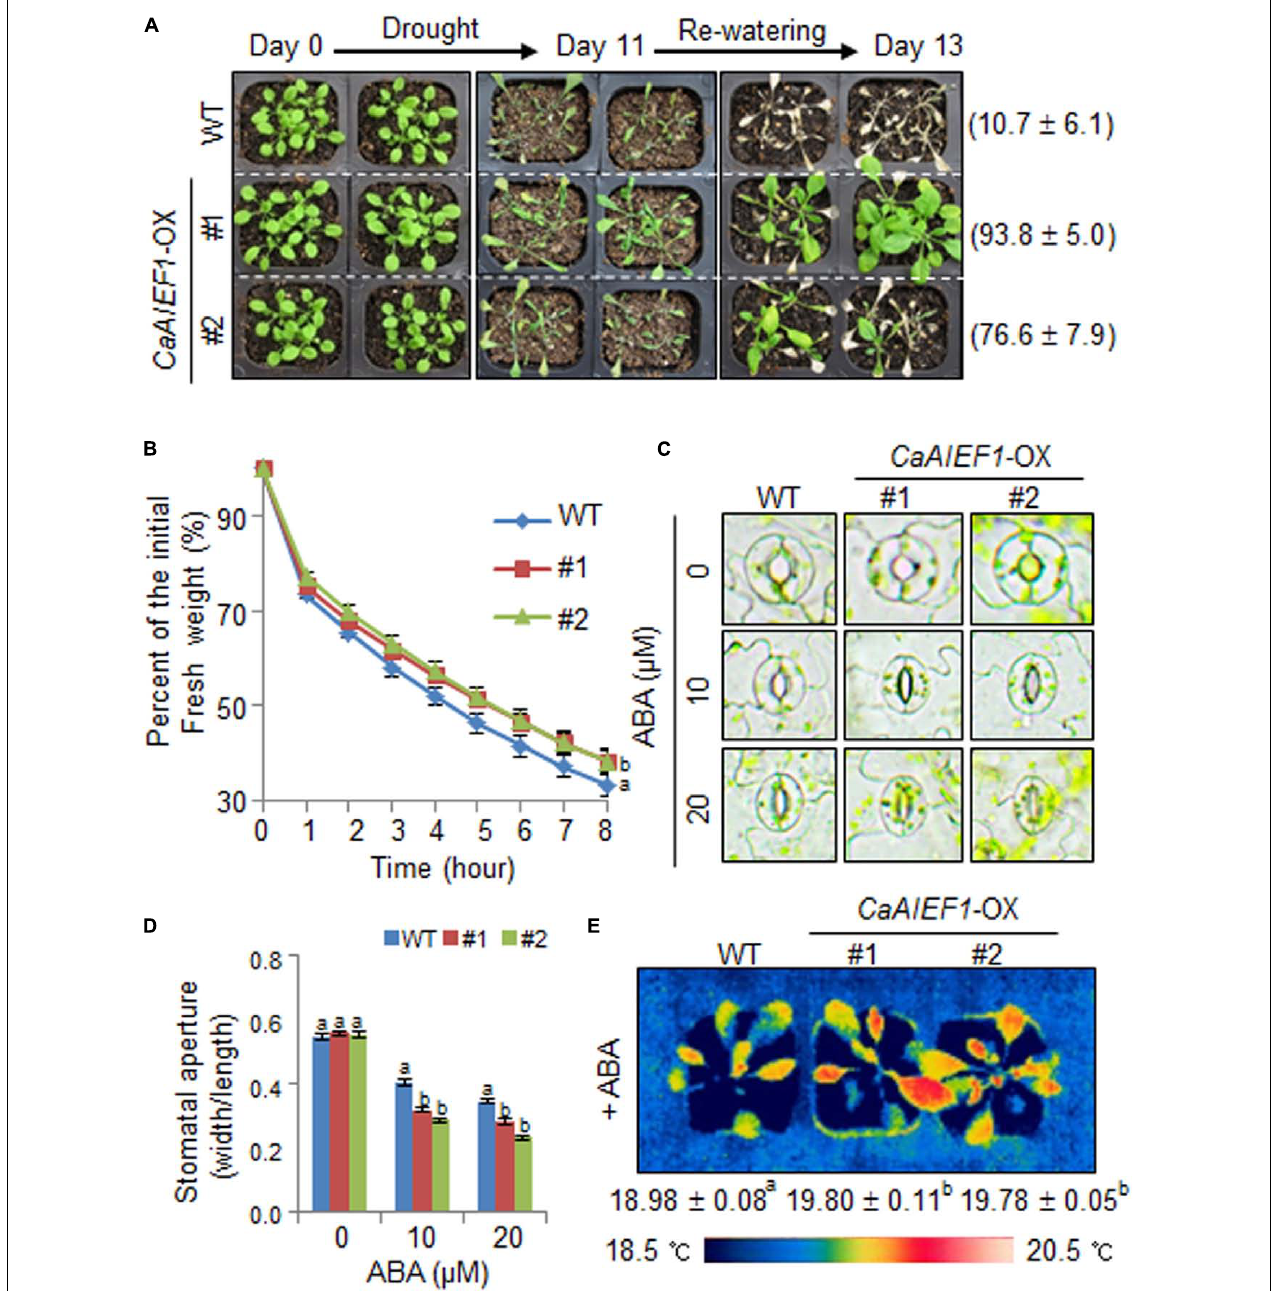
FIGURE 5 | Increased tolerance of CaAIEF1- OX plants to drought stress. (A) Drought-tolerant phenotype of CaAIEF1- OX transgenic plants. Four-week-old wild-type (WT) and transgenic plants were subjected to drought stress by withholding watering for 11 days and then re-watering for 2 days. Representative images were taken before (left) and after (middle) drought and after 2 days of re-watering (right). Survival rates of plants were calculated after 2 days of re-watering. Data represent the mean ± standard error of three independent experiments, each evaluating 20 plants. (B) Transpirational water loss from the leaves of WT and transgenic plants at various time points after detachment of rosette leaves. Data represent the mean ± standard error of three independent experiments, each evaluating 50 leaves. (C,D) Stomatal apertures in WT and CaAIEF1- OX plants treated with ABA. Leaf peels were harvested from 4-week-old plants of each line and incubated in stomatal opening solution (SOS) buffer containing the indicated concentrations of ABA. Representative images were taken under a microscope (C) and the stomatal apertures were measured (D) . Data represent the mean ± standard error of three independent experiments. (E) Increased leaf temperatures of CaAIEF1- OX plants in response to ABA treatment. Data represent the mean ± standard error of three independent experiments, each evaluating 10 plants. Different letters indicate significant differences (ANOVA; P < 0.05).